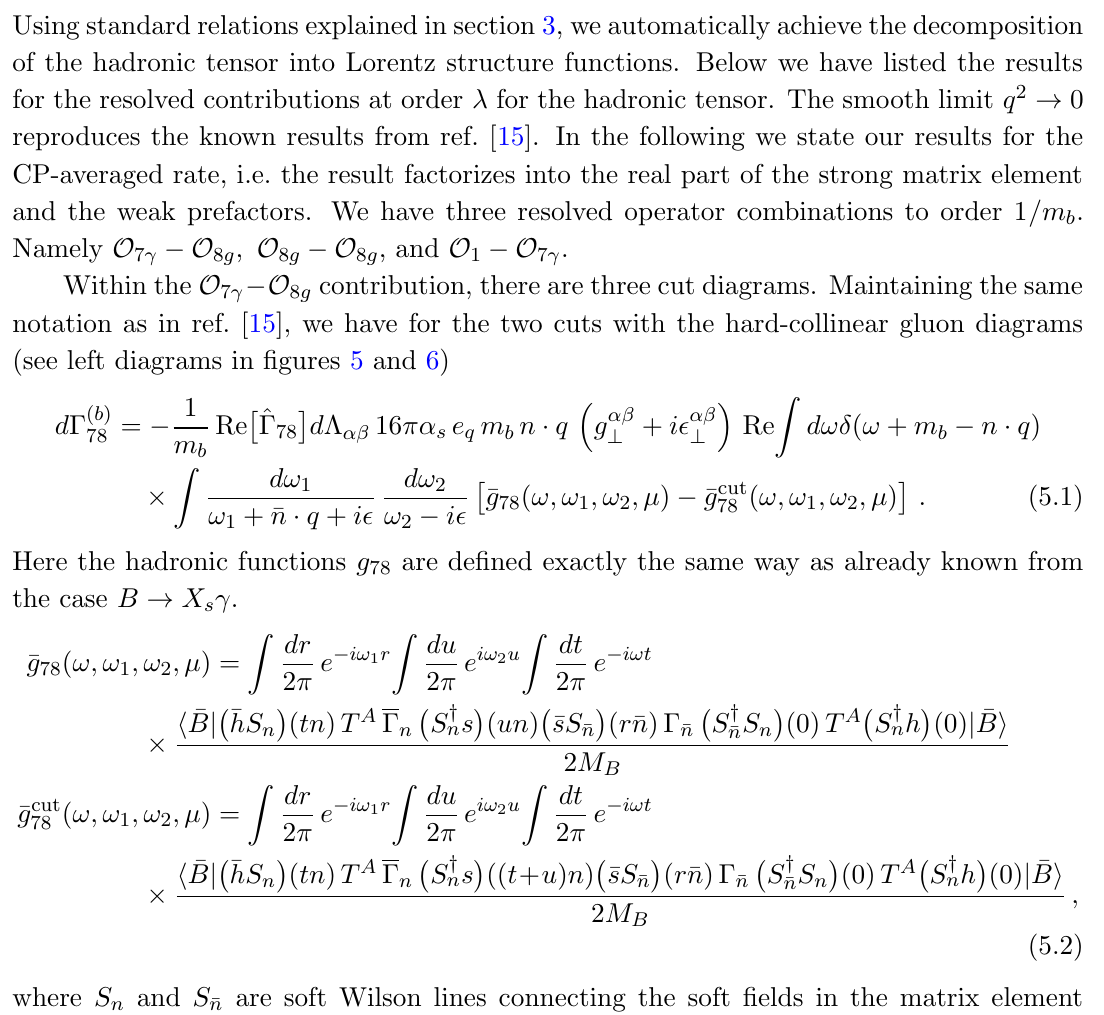
Figure 5 . Three cut diagrams arising from the matching of the Red indicates soft (cid:12)elds, black (anti-) hard-collinear (cid:12)elds. Hard (cid:12)elds are already integrated out. The left diagram with a hard-collinear gluon allows for two di(cid:11)erent cuts, while the diagram with the anti-hard-collinear gluon allows for one cut